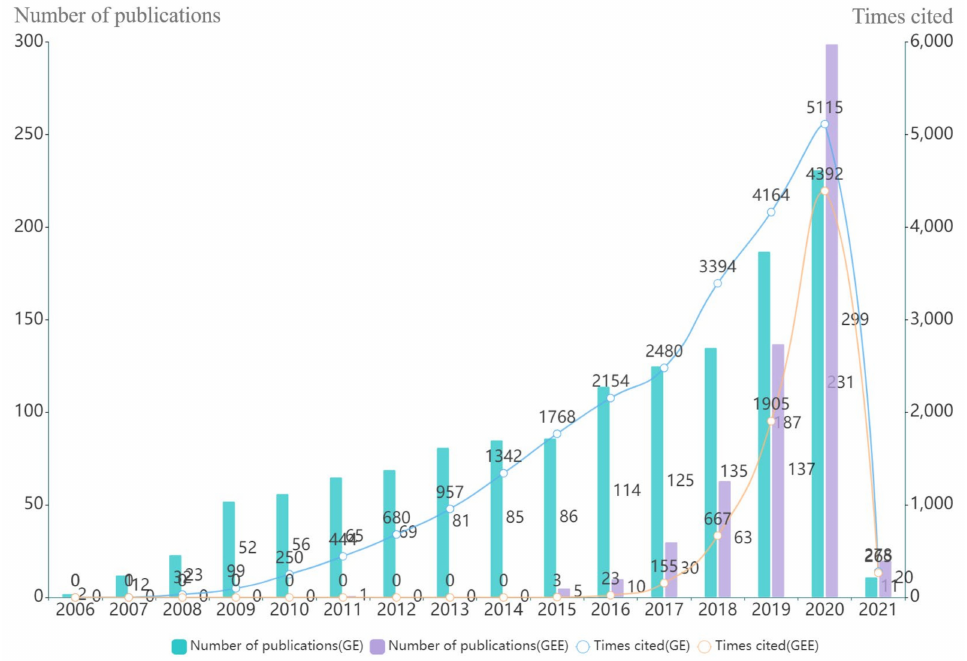
Figure 1. Change in the number of publications and citations relevant to GE and GEE (dated up to January